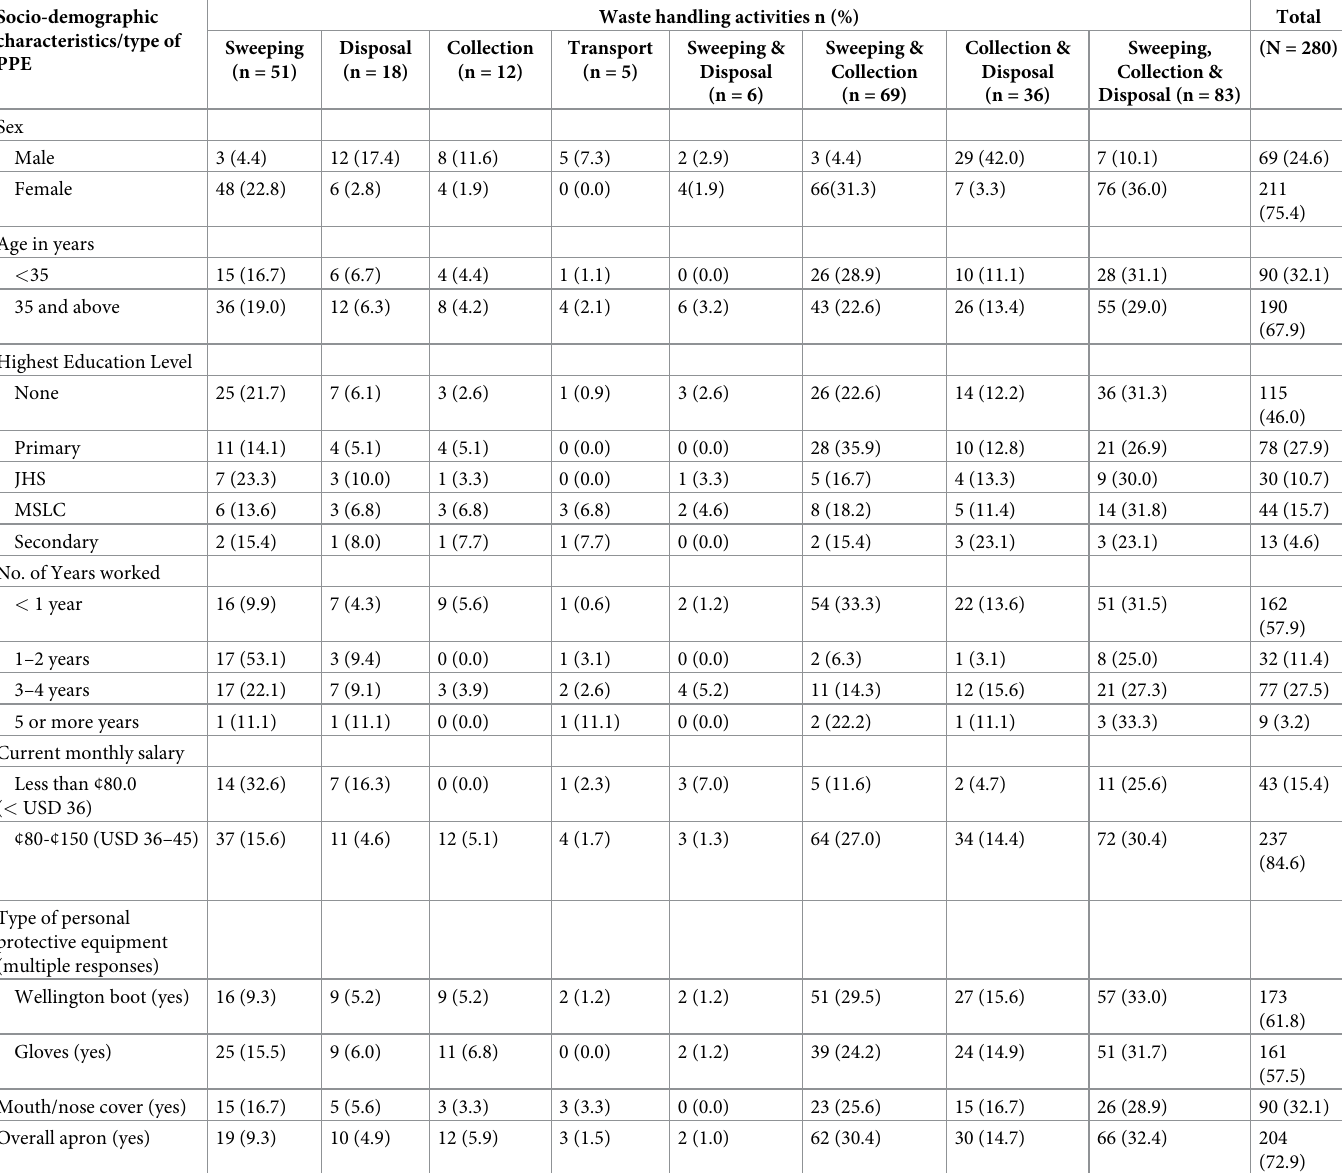
Table 1. Socio-demographic characteristics and type of personal protective equipment (PPE) by waste handlers performing different activities. Socio-demographic characteristics/type